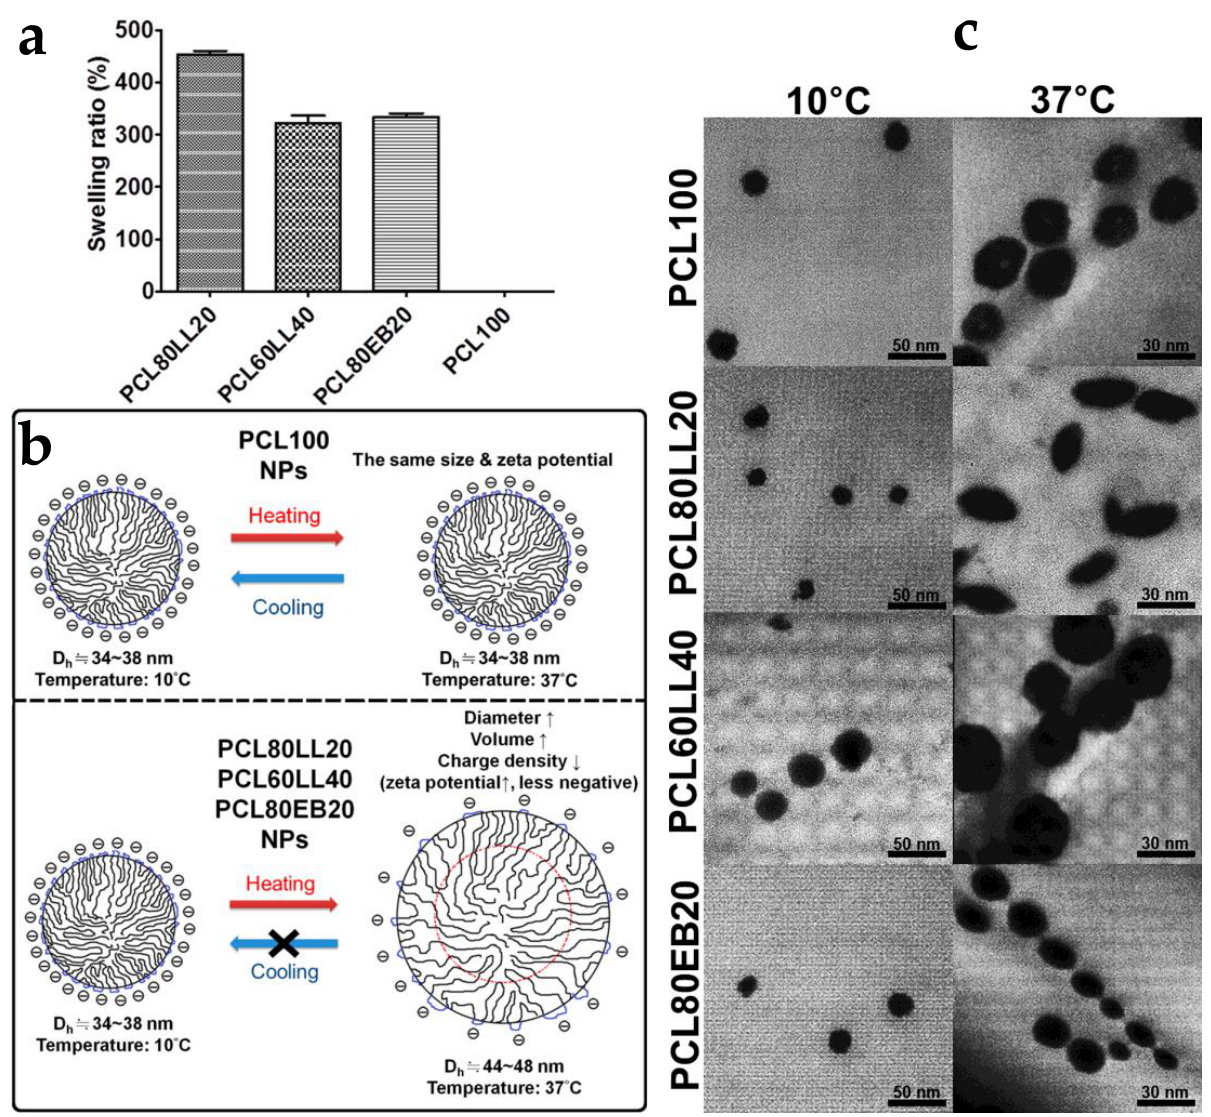
Figure 12. ( a ) Equilibrium swelling ratio (%) of waterborne biodegradable PU NP dispersions at 37 °C. ( b ) A summary of swelling and the size change for the PU NPs. ( c ) TEM images for various PU NPs at two different temperatures, 10 and 37 °C (adapted with permission from [92]).